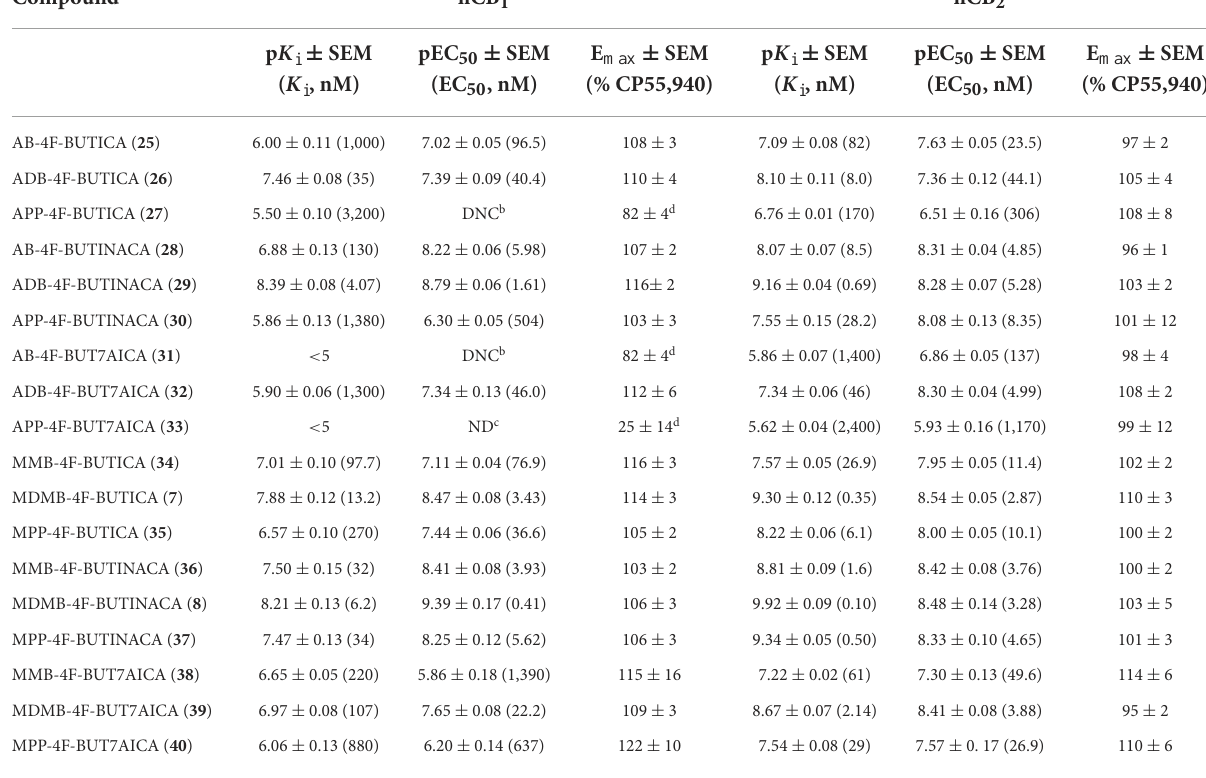
TABLE 2 Affinities and functional activities of 4-fluorobutyl derived SCRAs at hCB 1 and hCB 2 .